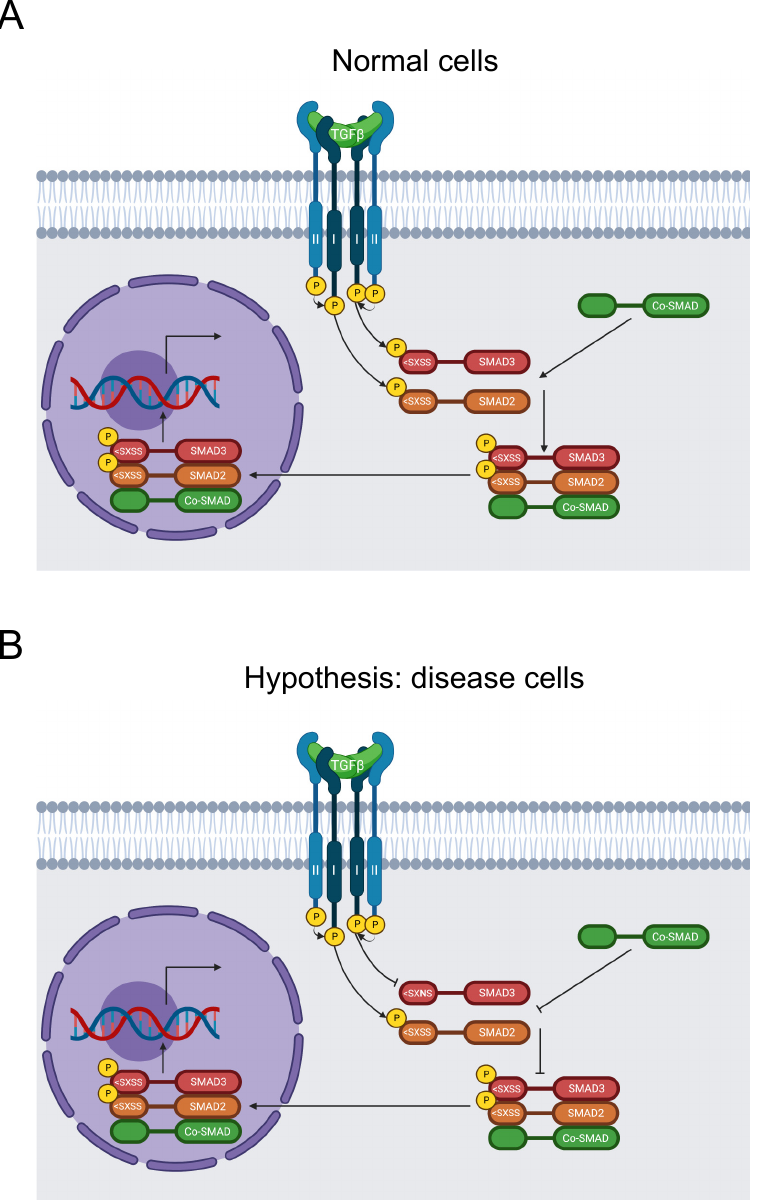
Figure 8. Diagram of the SMAD signaling pathway. ( A ) TGF- β binds to T β RII and subsequently recruits T β RI. T β RII subsequently activates T β RI by phosphorylation, which transduces the signal